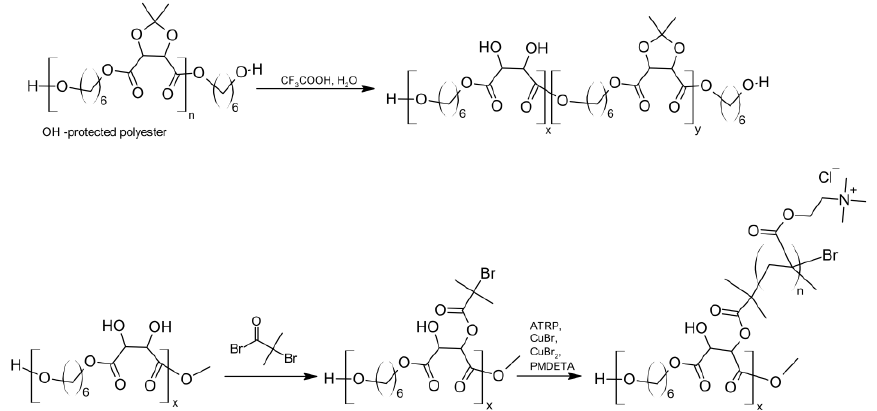
Figure 19. Scheme of biodegradable polyester with hydroxyl groups synthesis and process immobilizations of the cationic brushes [338].